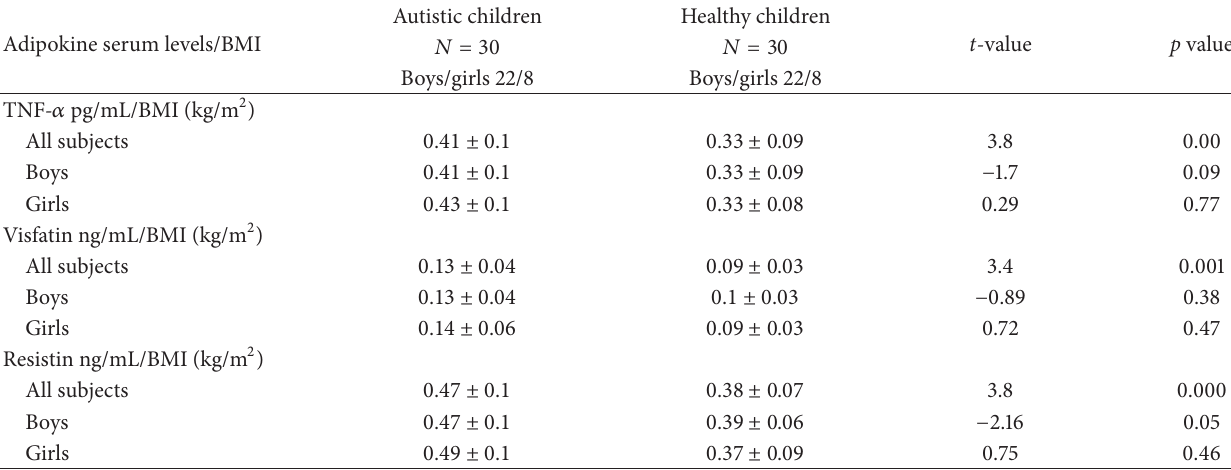
Table 3: The adipokine serum levels/BMI ratio in autistic children and healthy controls.